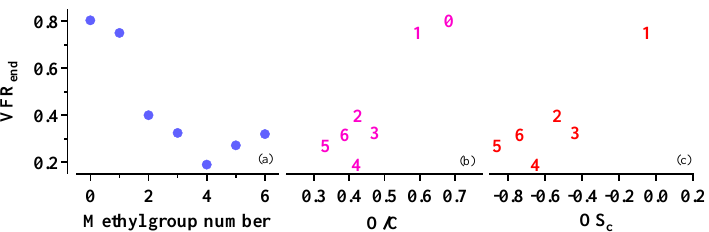
Figure 6. Relationship between (a) SOA volatility and methyl group number, (b) SOA volatility and O/C, and (c) SOA volatility and oxidation state (OS c ) from monocyclic aromatic hydrocarbon photooxidation under low NO x (number mark represents number of methyl groups on aromatic hydrocarbon